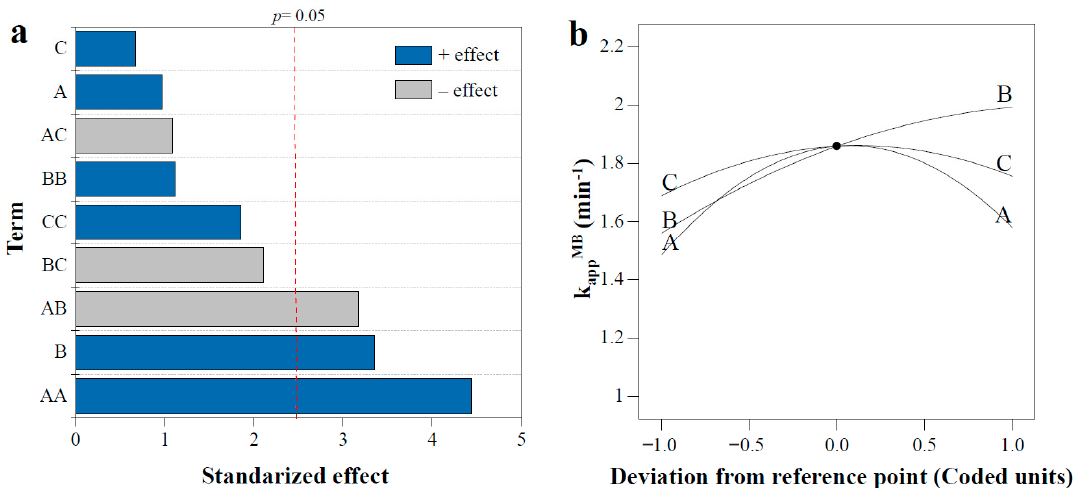
Figure 3. ( a ) Pareto chart showing the standardized e ff ects of variables (first order, quadratic and interaction terms) on k app MB (vertical line represents the 95% confidence interval), and ( b ) Perturbation graphs for k app MB (A-[H 2 O 2 ] / [Fe 2 + ], B-[Fe 2 + ],